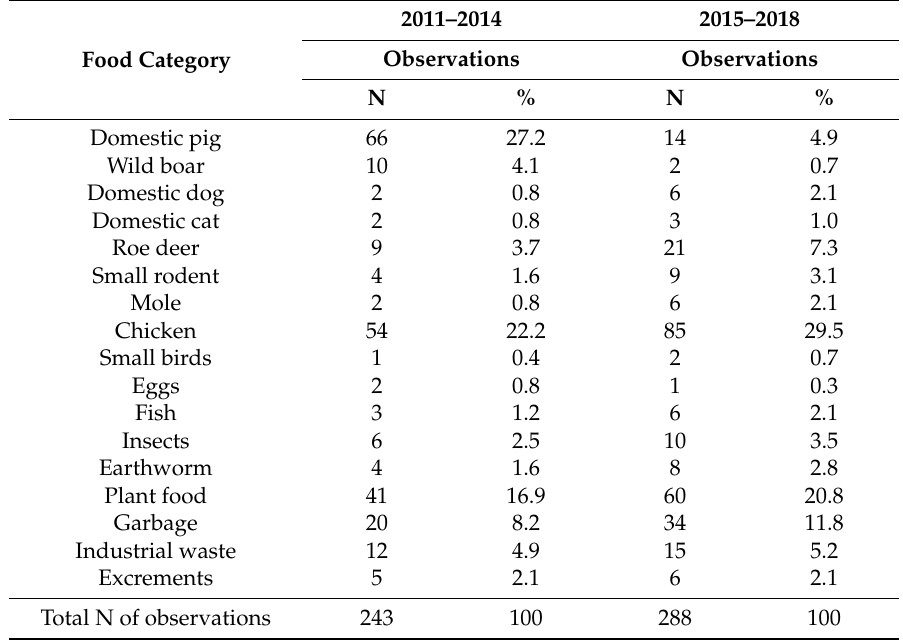
Table 3. Dietary composition of ravens in Central Poland in the two (‘pre ASF’ and ‘ASF outbreak’) periods on the basis of direct observations of feeding